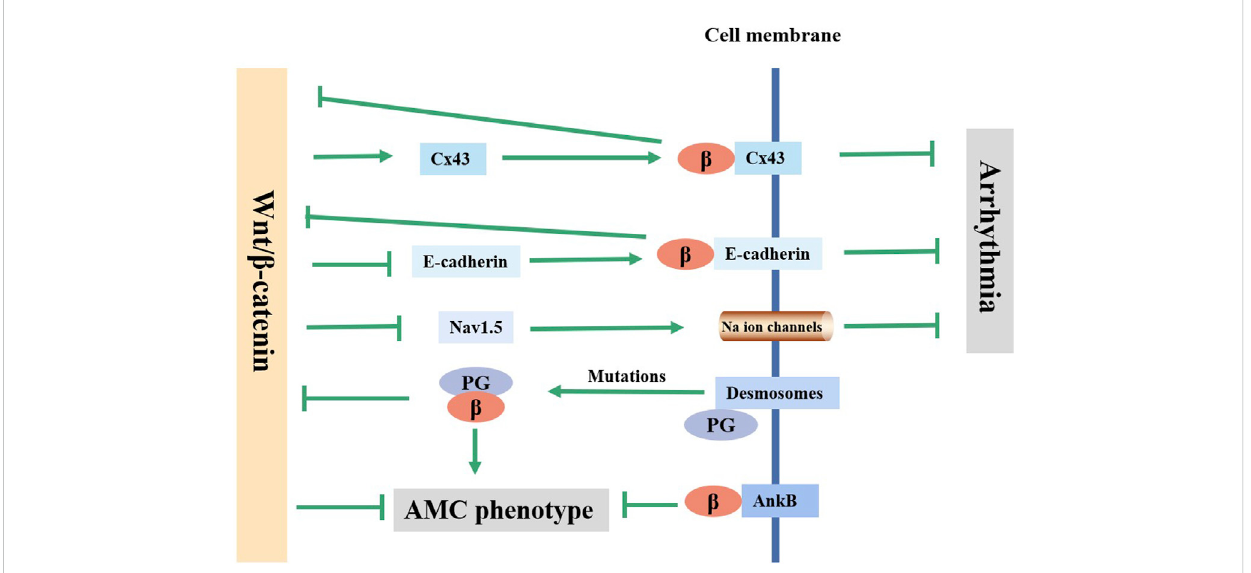
FIGURE 2 Current knowledgeon theregulatory mechanism ofWnt/ β -catenin pathwayin arrhythmia and ACM. Wnt/ β -catenin pathway affects thearrhythmia through regulating the expression of Cx43, E-cadherin and Nav1.5. Mutations in the desmosomal gene can lead to PG free, which inhibits the canonical Wnt/ β -catenin pathway and causes AMC phenotype. AnkB inhibits AMC phenotype by co-localizing with β -catenin on the on the